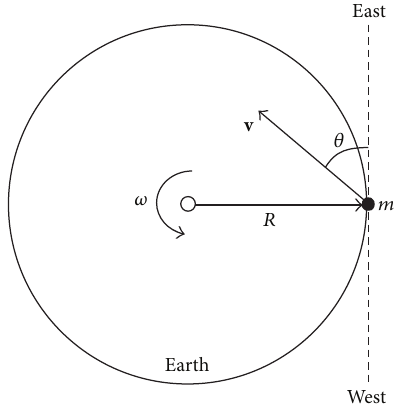
Figure 1: A bolide of mass 𝑚 and velocity k relative to Earth’s center impacts Earth with an angle 𝜃 from the eastward direction. The velocity vector of the bolide just before the impact lies in the equatorial